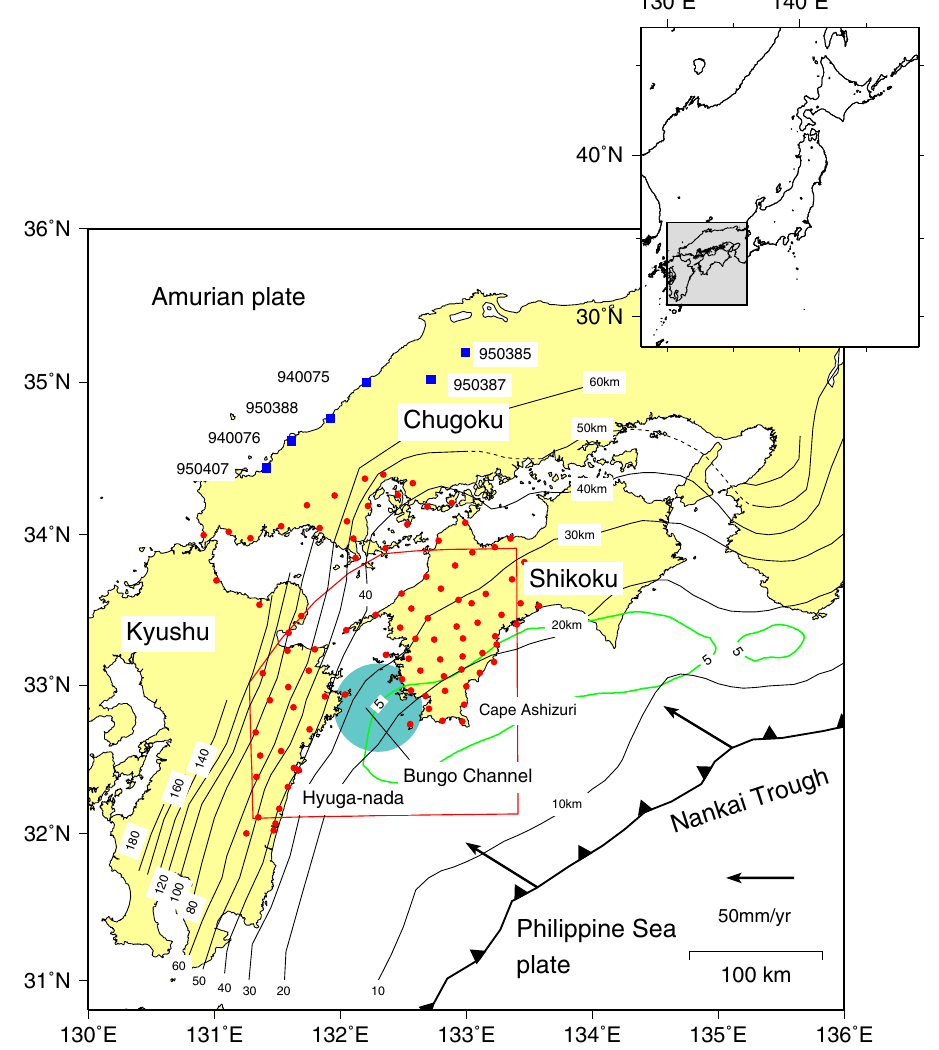
Figure 1. Tectonic map in and around the Bungo Channel, southwest Japan. The thin black lines represent isodepth contours of the upper surface of the Philippine Sea (PHS) plate subducting from the Nankai Trough, represented by the thick barbed black line. The 10 km, 20–50 km, and > 60 km contour lines are taken from Baba et al. 11 , Hirose et al. 12 , and Nakajima and Hasegawa 13 , respectively. The arrows indicate the plate motion velocity vector of the PHS plate with respect to the Amurian (AM) plate estimated by DeMets et al. 1 . The light- blue solid circle denotes the approximate location where the Bungo Channel slow slip events took place. The red solid circles and blue solid squares denote the GNSS stations used for the inversion analysis in this study and reference stations to calculate the common-mode error, respectively. The green line denotes the contour of 5 cm/yr of slip deficit rate of Model 1 of Yoshioka and Matsuoka 14 . The grey squared area in the inset is the study region in the map of the Japanese islands. The map was created by using the Generic Mapping Tools (GMT)